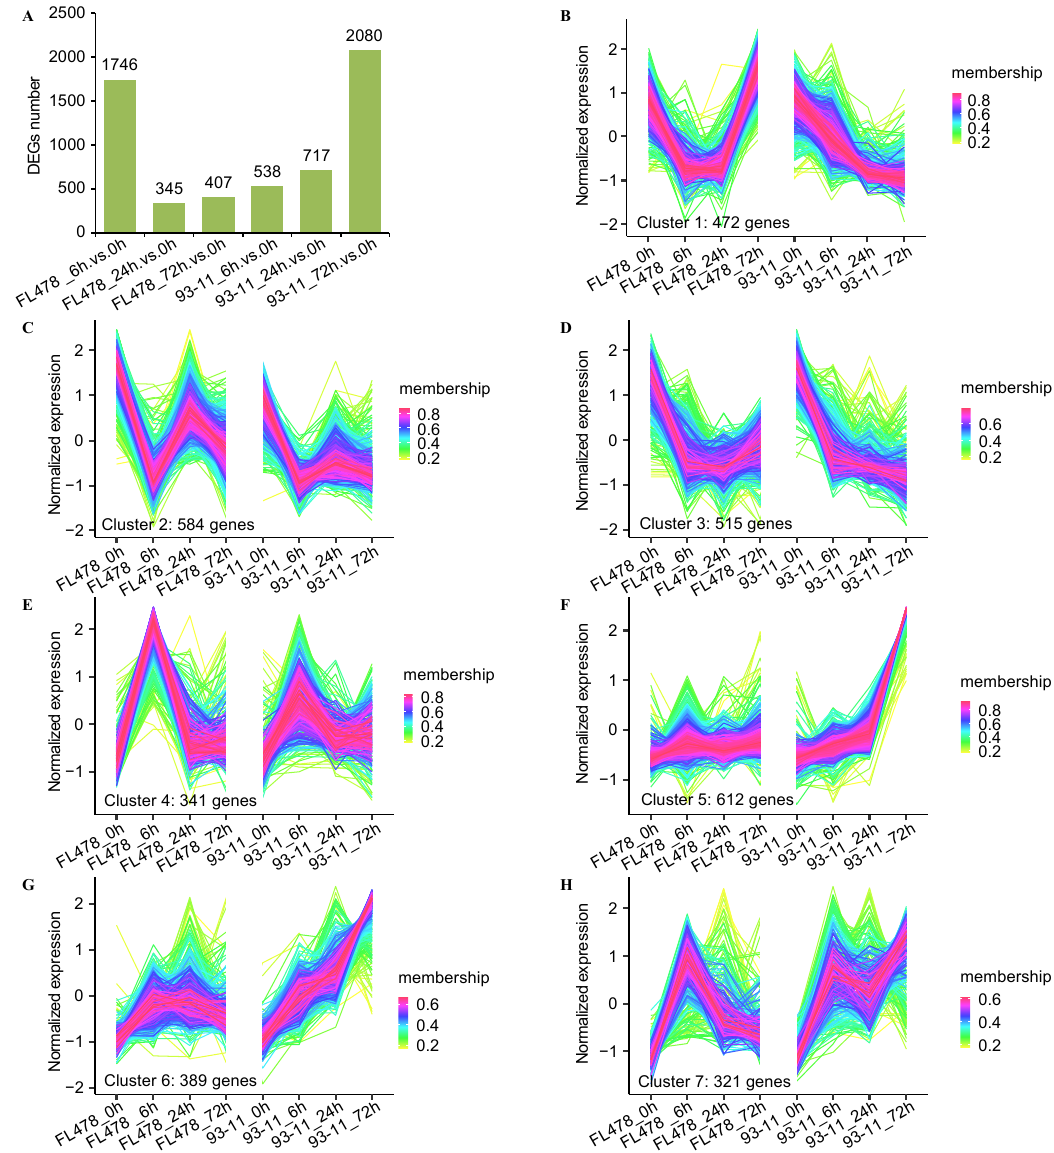
Figure 1. The DEGs identified in FL478 and 93-11 upon salt treatment. ( A ) The number of DEGs detected in FL478 and 93-11 under salt conditions. ( B – H ) Seven gene clusters of all the DEGs. Membership values indicate the degree of genes belonging to the clusters.